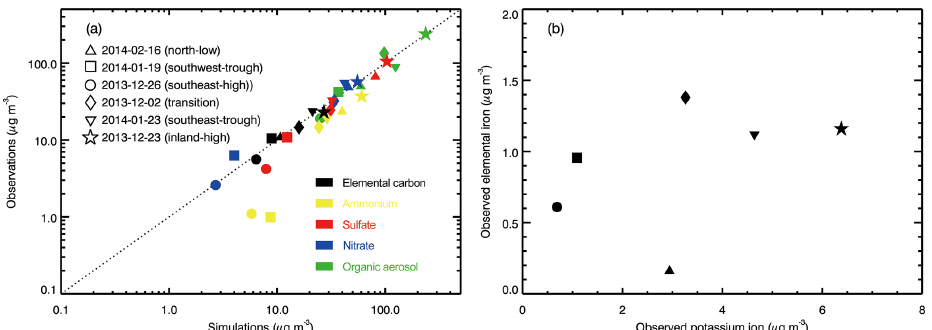
Figure 11. Scatter plot of (a) the measured vs. modeled daily mean mass concentration of aerosol constituents and (b) the elemental iron with potassium measured by filter samples at IEECAS site on the selected 6